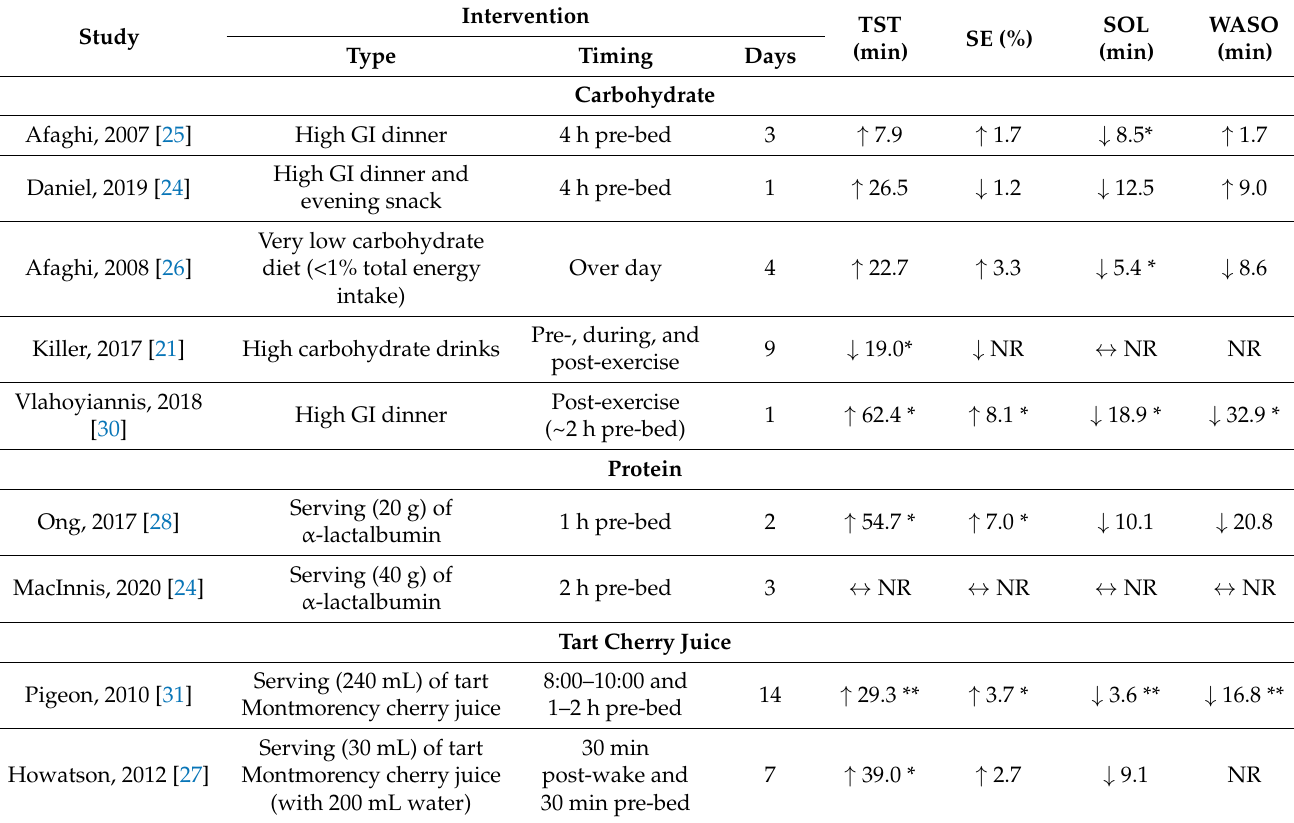
Table 2. Changes to sleep following carbohydrate, protein, tart cherry juice, and other nutritional interventions.